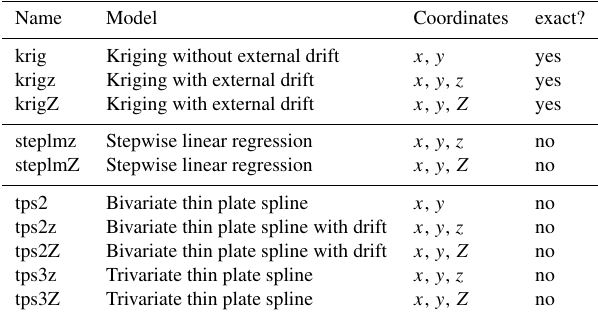
Table 3. Mapping models considered in this study, with involved coordinates. Kriging method provides exact interpolation, unlike the linear regression and thin plate